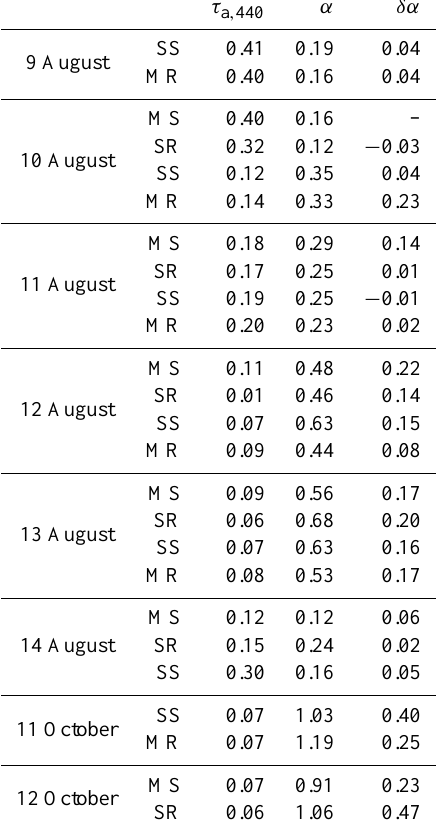
Table 8. Averaged values of τ a (in 440 channel), α (Angstr¨om ex- ponent) and δα obtained in August and October 2011, case studies. Values are for SS (sunset), MR (moonrise), MS (moonset) and SR